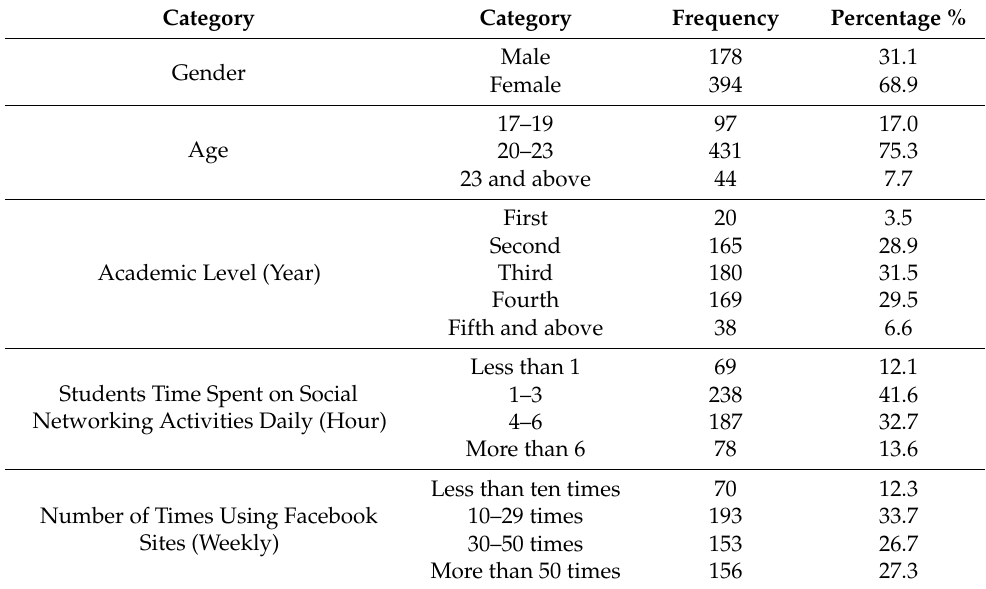
Table 3. Characteristics of the research sample ( n =